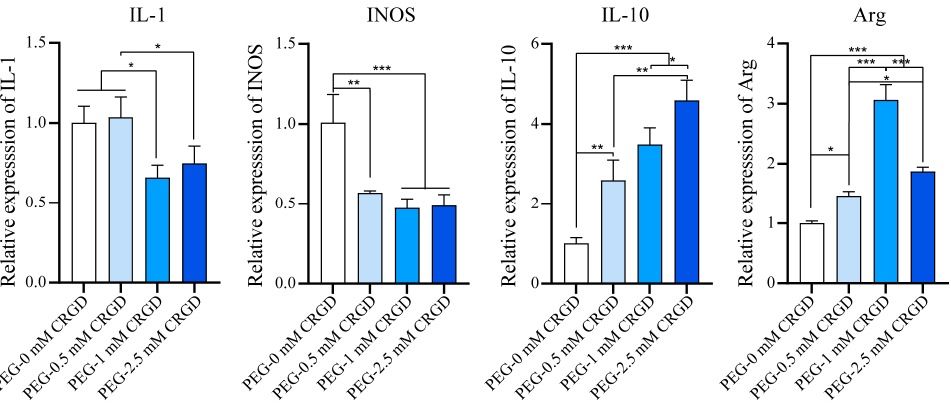
Figure 5. The mRNA levels of the M1(IL-1 and INOS)/M2(IL-10 and Arg) macrophages biomarkers of RAW264.7 in hydrogels. * p < 0.05, ** p < 0.01, *** p < 0.001.